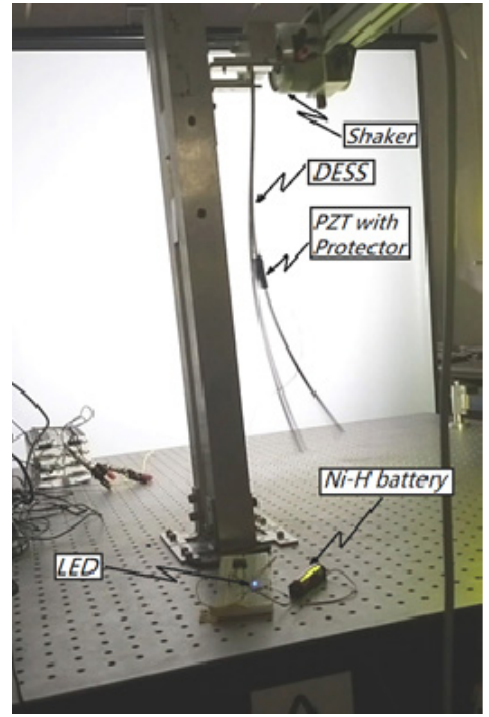
Figure 1. Experimental model of double elastic steel sheet (DESS).